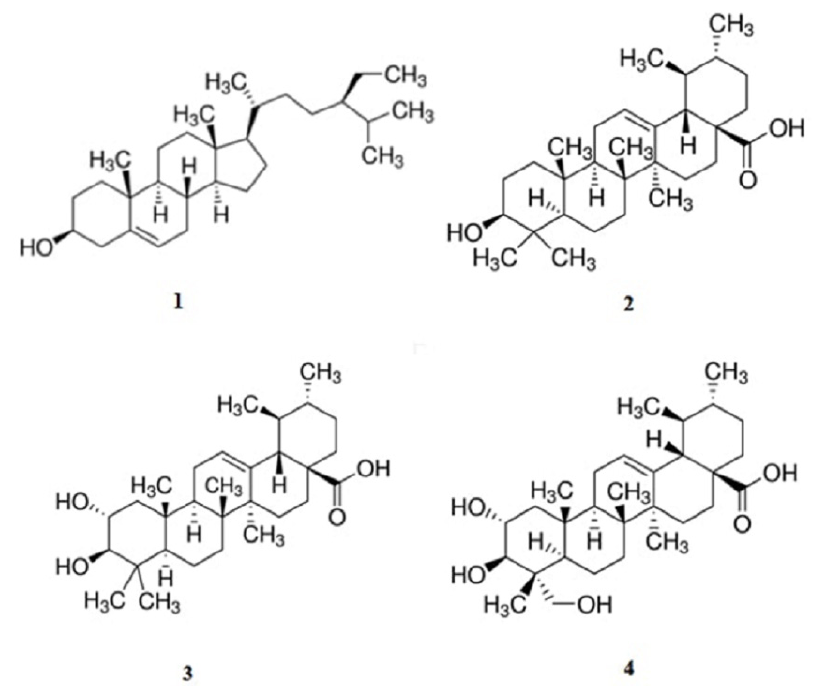
Figure 5. Triterpenoids